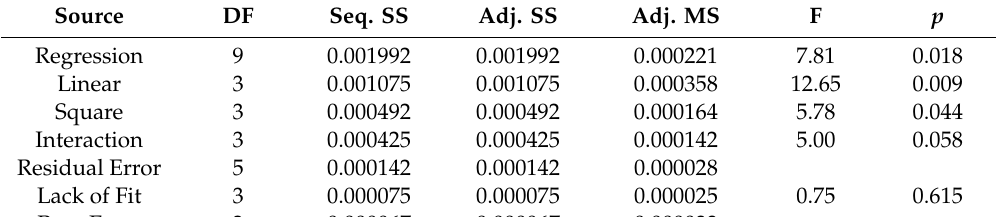
Table 8. ANOVA test results of response surface model for KW.